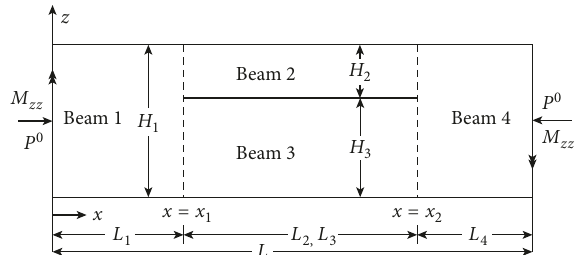
Figure 1: Schematic illustration of a beam with single delamination under axial load and end